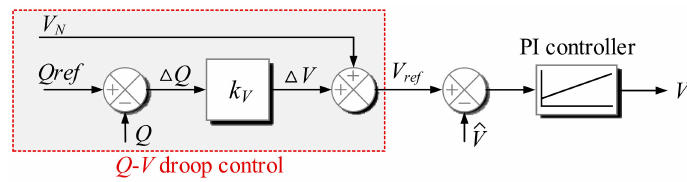
Figure 5. Structure of excitation regulation part with inner Q - V droop